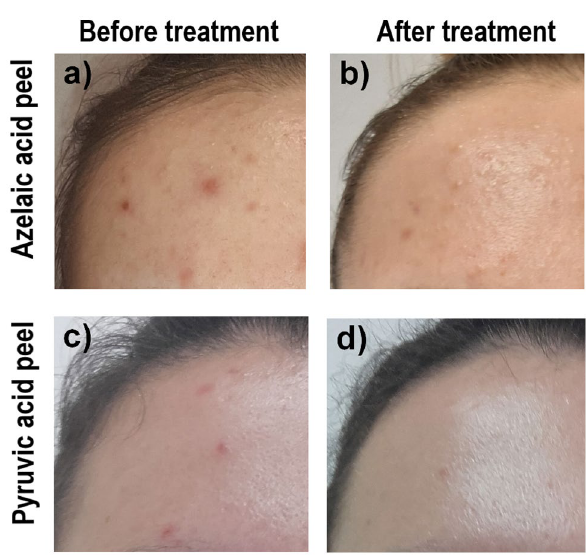
Figure 3. Consort flow chart of clinical study Group 1 and Group 2.